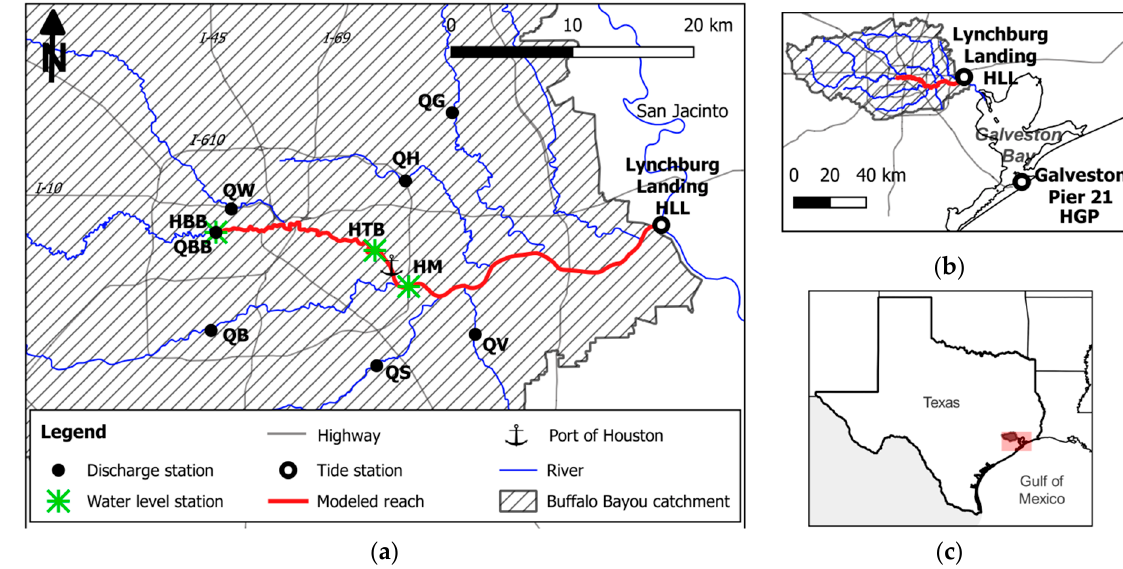
Figure 2. Location of the case study area, the Buffalo Bayou catchment ( a ) which drains into the Galveston Bay ( b ) and connected to the Gulf of Mexico ( c ). The discharge stations (filled circles in black) and the tide station (empty circles) Galveston Pier 21 are used to construct the BN and model water surface elevations along the main stem of the Buffalo Bayou catchment (red line). Water level stations (green) were used for the comparison with the modeled extreme water levels.